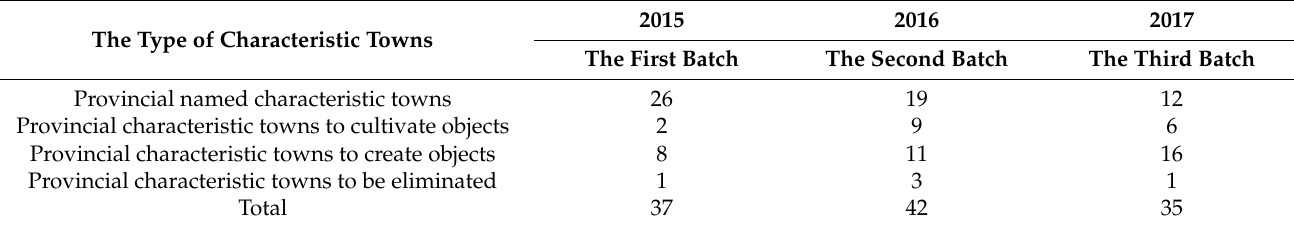
Table 1. The first three batches of provincial characteristic towns in Zhejiang